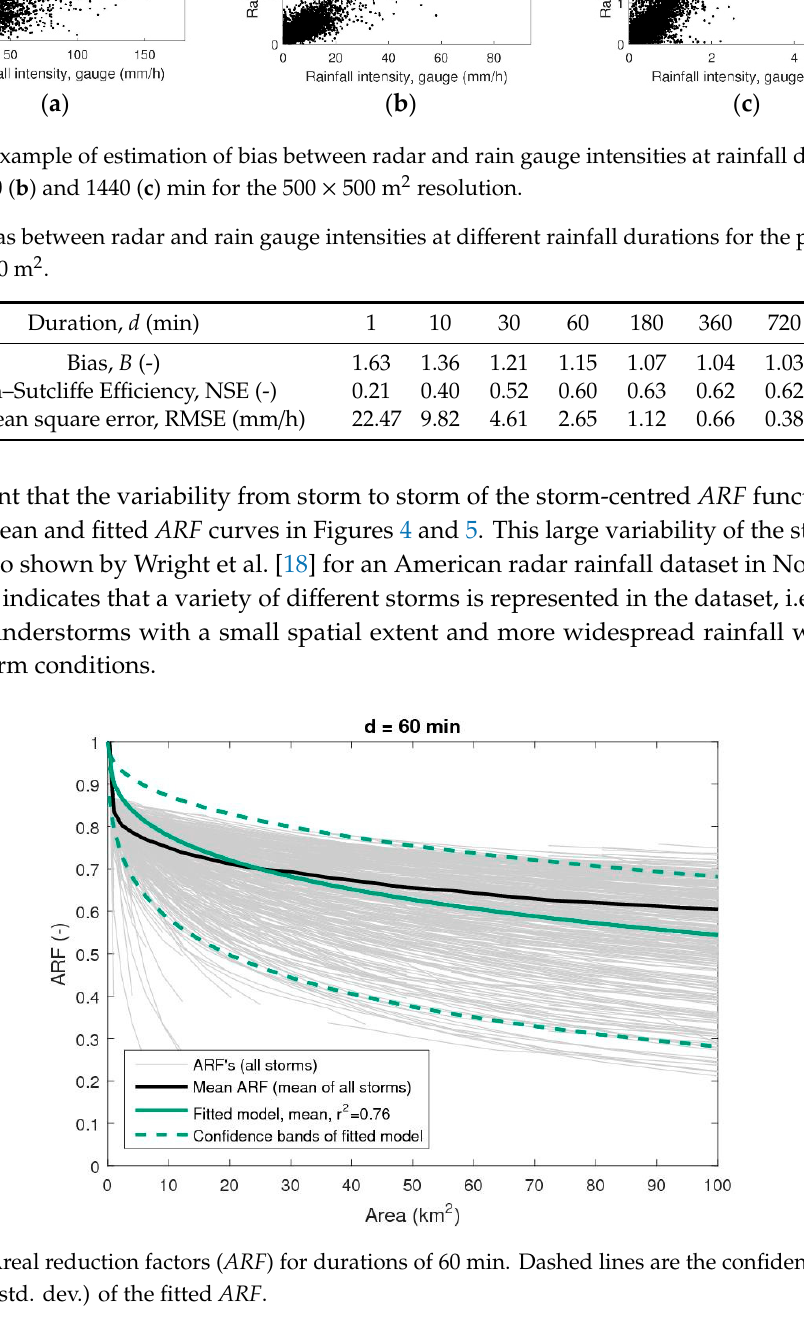
Figure 5. ARF for durations of 360 min. Dashed lines are the confidence limits (mean +/ − std. dev.) of the fitted ARF .